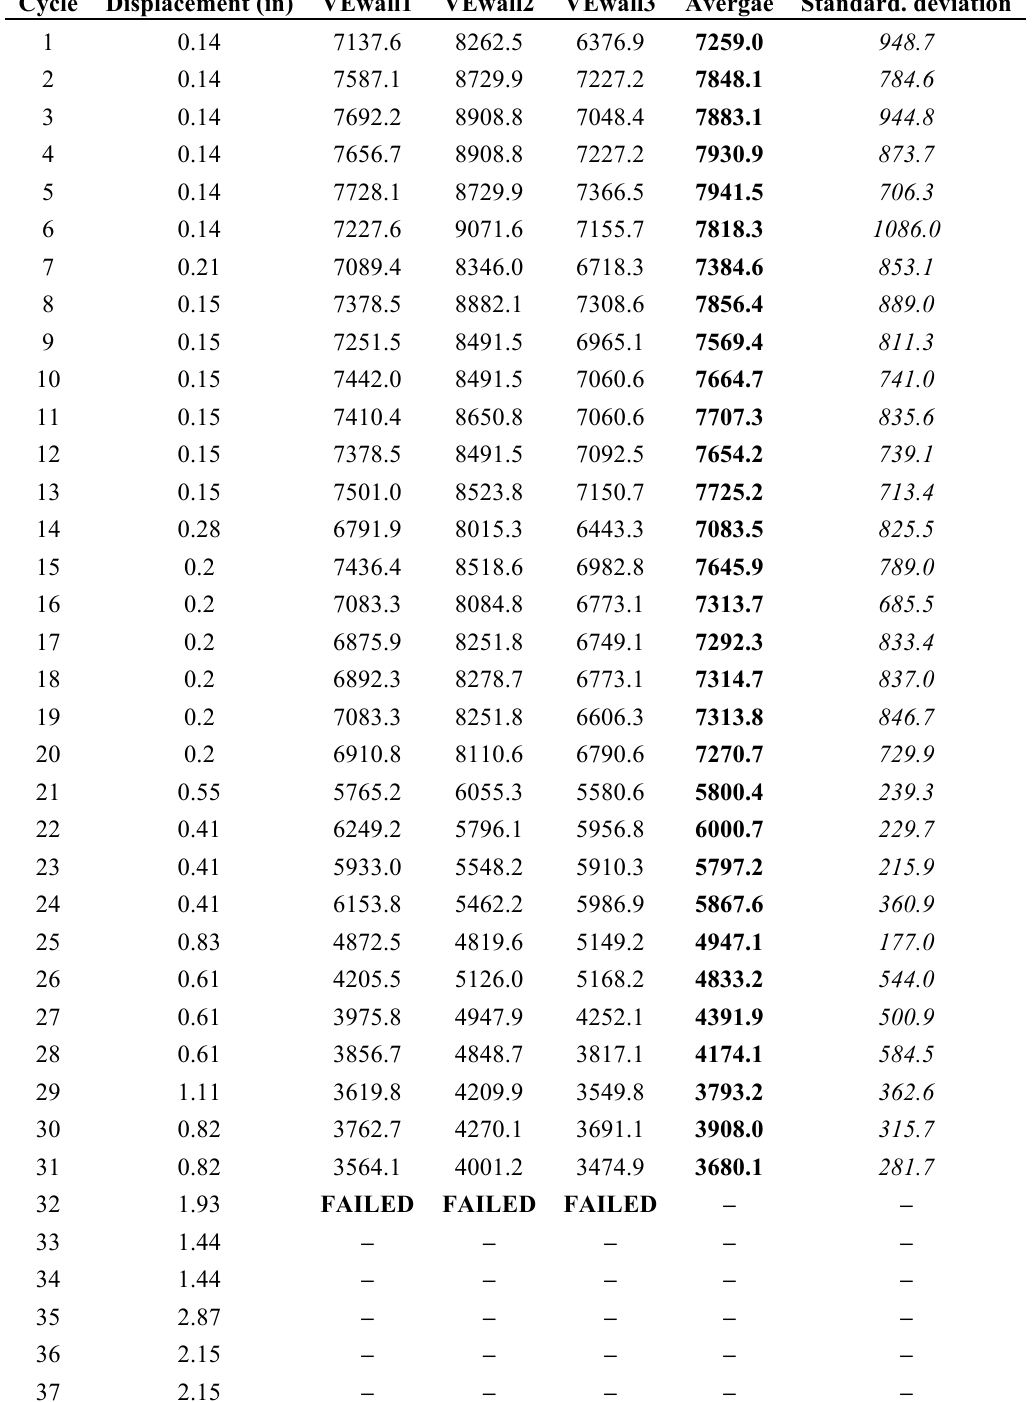
Table 6. Stiffness (lb/in) of